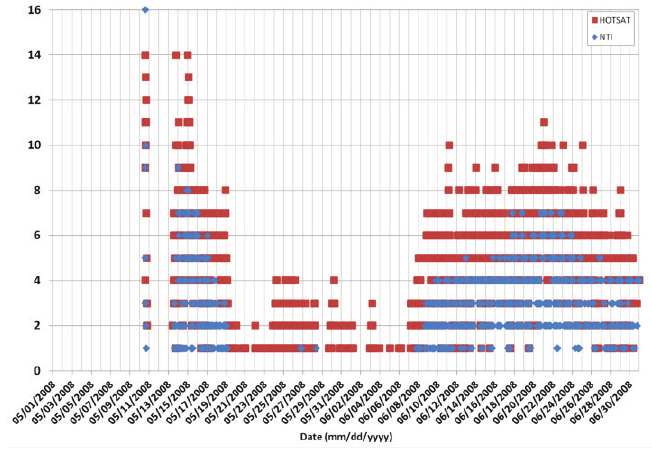
Figure 3. Hotspot numbers detected by the normalized thermal index algorithm (blue) and the HOTSAT hotspot detection algorithm (red), during May and June, 2008, for the SEVIRI data.